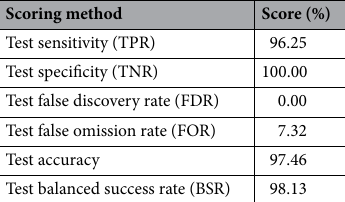
Table 4. Statistical scores (lyme = positive) for classification of test samples restricted to 42 selected biomarkers with LCMS classifier using log transformed